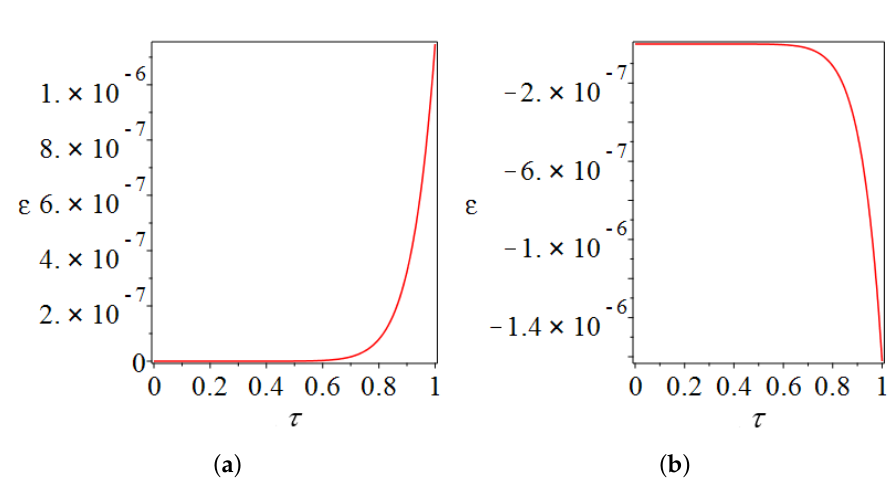
) / ϕ Figure 6. Error ε = ( ϕ i − ϕ analytic 20 of Greenspan I method for ( a ) ϕ 1 and ( b ) ϕ 2 angles for i a single time step. τ = 1 means ≈ 5 largest periods and ≈ 12 smallest